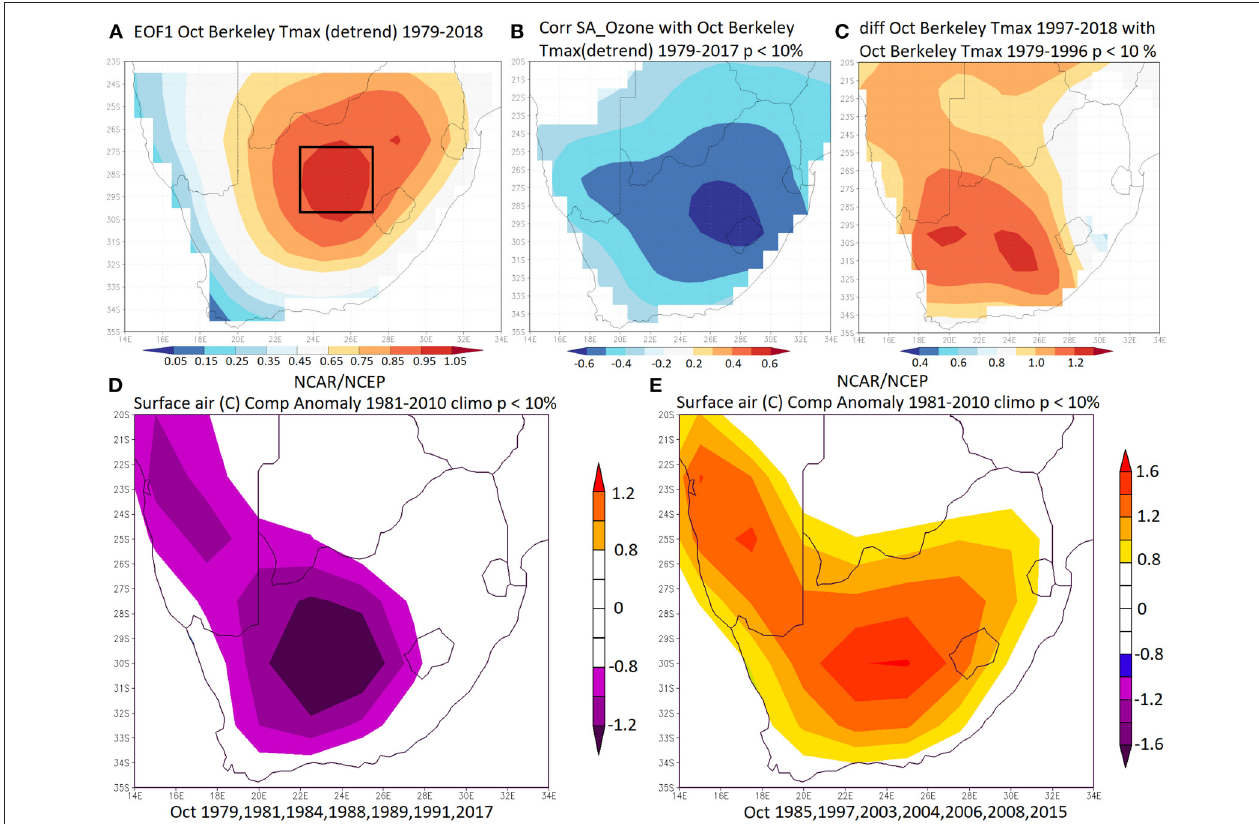
FIGURE 2 | The spatial pattern of (A) SATmax_EOF1 with the boxed region demarcating the location where the averaged values of the indices were derived from, (B) correlation between SA_ozone index and SATmax, (C) mean difference between SATmax of the 1997–2017 and 1979–1996 epochs and surface mean temperature composite for (D) wBDC and (E) sBDC. All the data are for October from 1979 to 2017 and the significance (colored shades) is for 90% confidence level using the 2 tailed t-test.